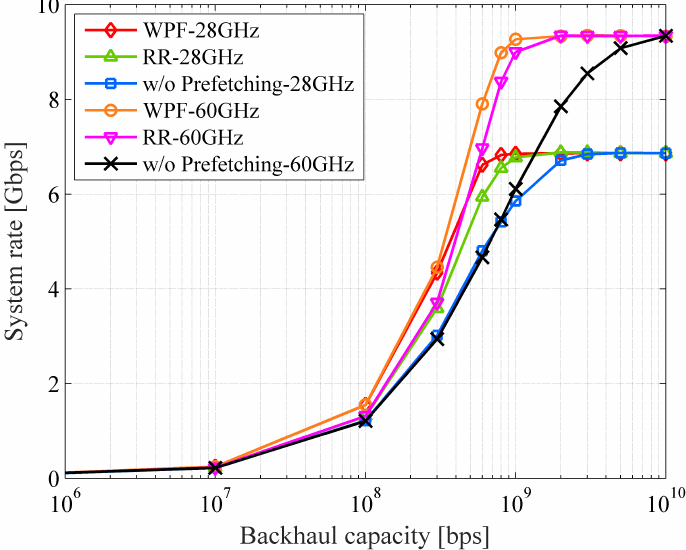
Figure 8. The system rate vs. the backhaul capacity.